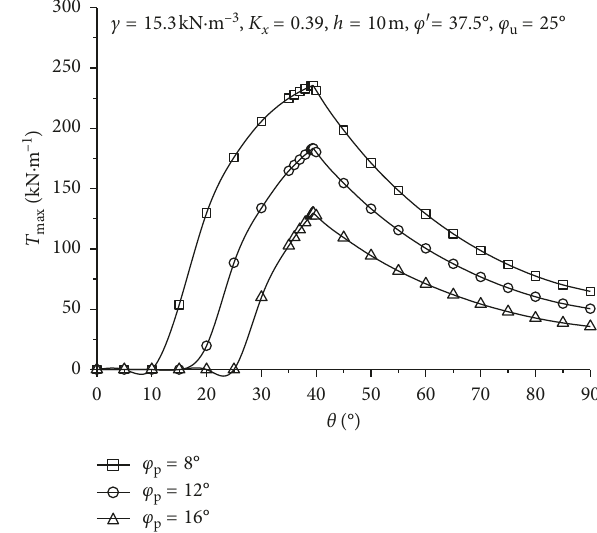
Figure 5: Change of the ultimate tensile force in the antiseepage membrane with the slope